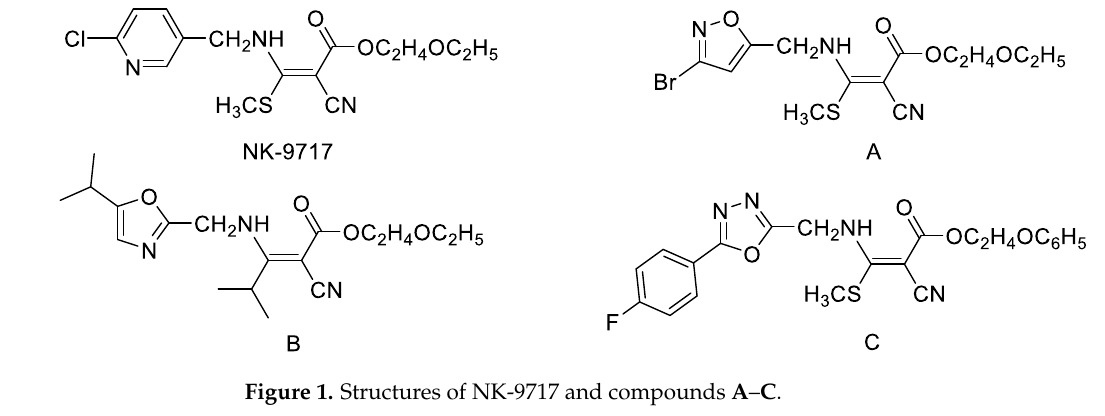
Figure 1. Structures of NK-9717 and compounds A – C.